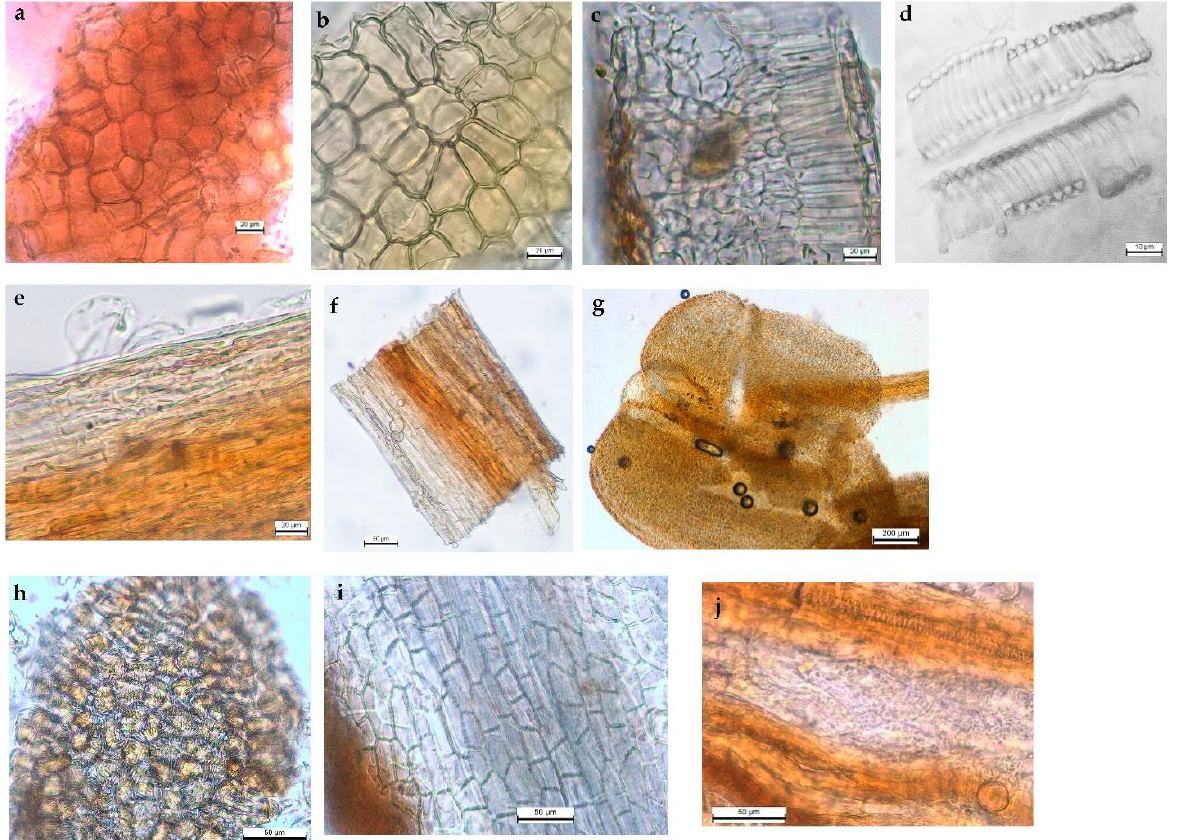
Figure 4. H. foliosum powder microscopic characteristics. ( a ) Stem phellem cells (top view); ( b ) stem parenchymatous cell (top view); ( c ) leaf bifacial mesophyll (transverse section); ( d ) tracheids and vessels (top view); ( e ) staminal filament (top view); ( f ) staminal filament (top view); ( g ) anthers (top view); ( h ) anthers (top view); ( i ) petal epidermis (top view); ( j ) stigma (transverse section).